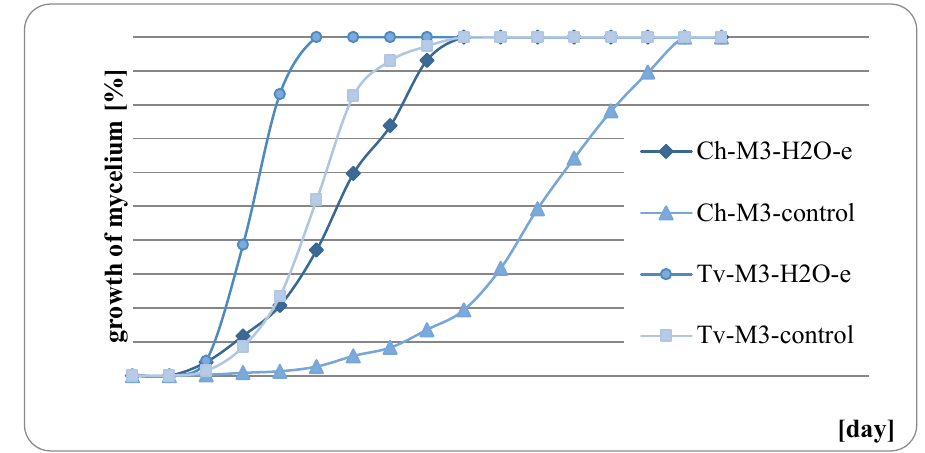
Figure 9. Growth of fungi on M. spicata ‘Morocco’ with and without extraction.